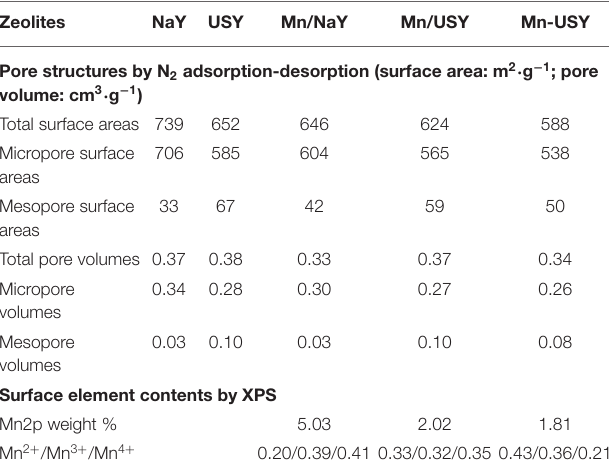
TABLE 1 | Zeolites pore structures determined by N 2 adsorption-desorption and surface element contents by XPS. Zeolites NaY USY Mn/NaY Mn/USY